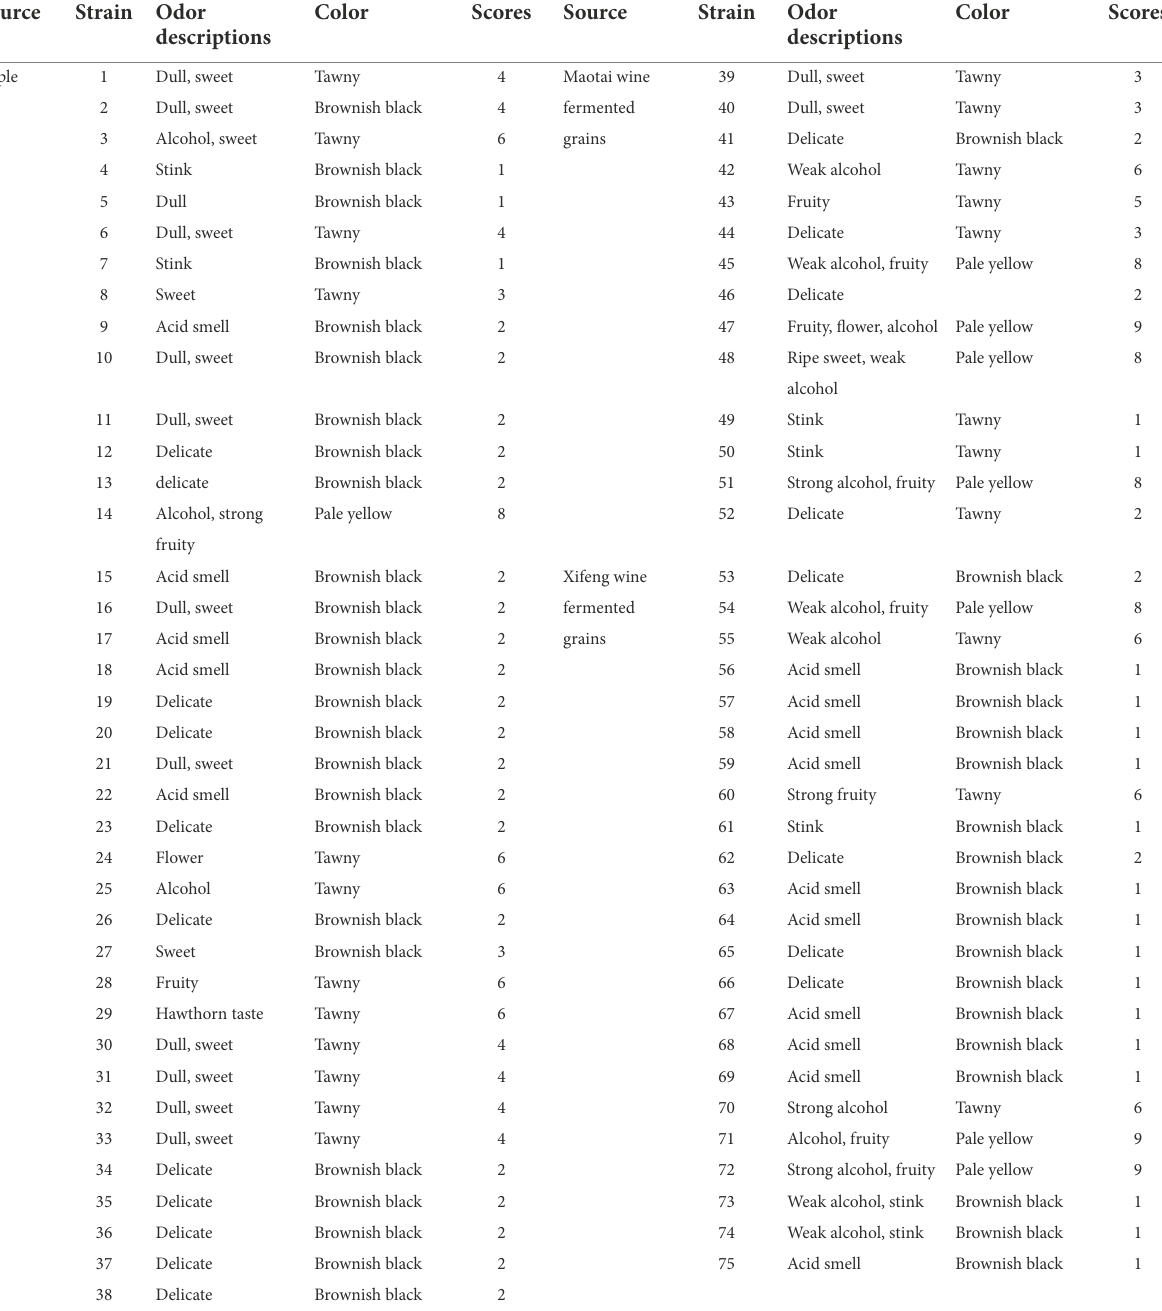
TABLE 1 Aroma-producing characteristics and sensory analysis of fermented ciders from 75 different yeasts. Source Strain Odor